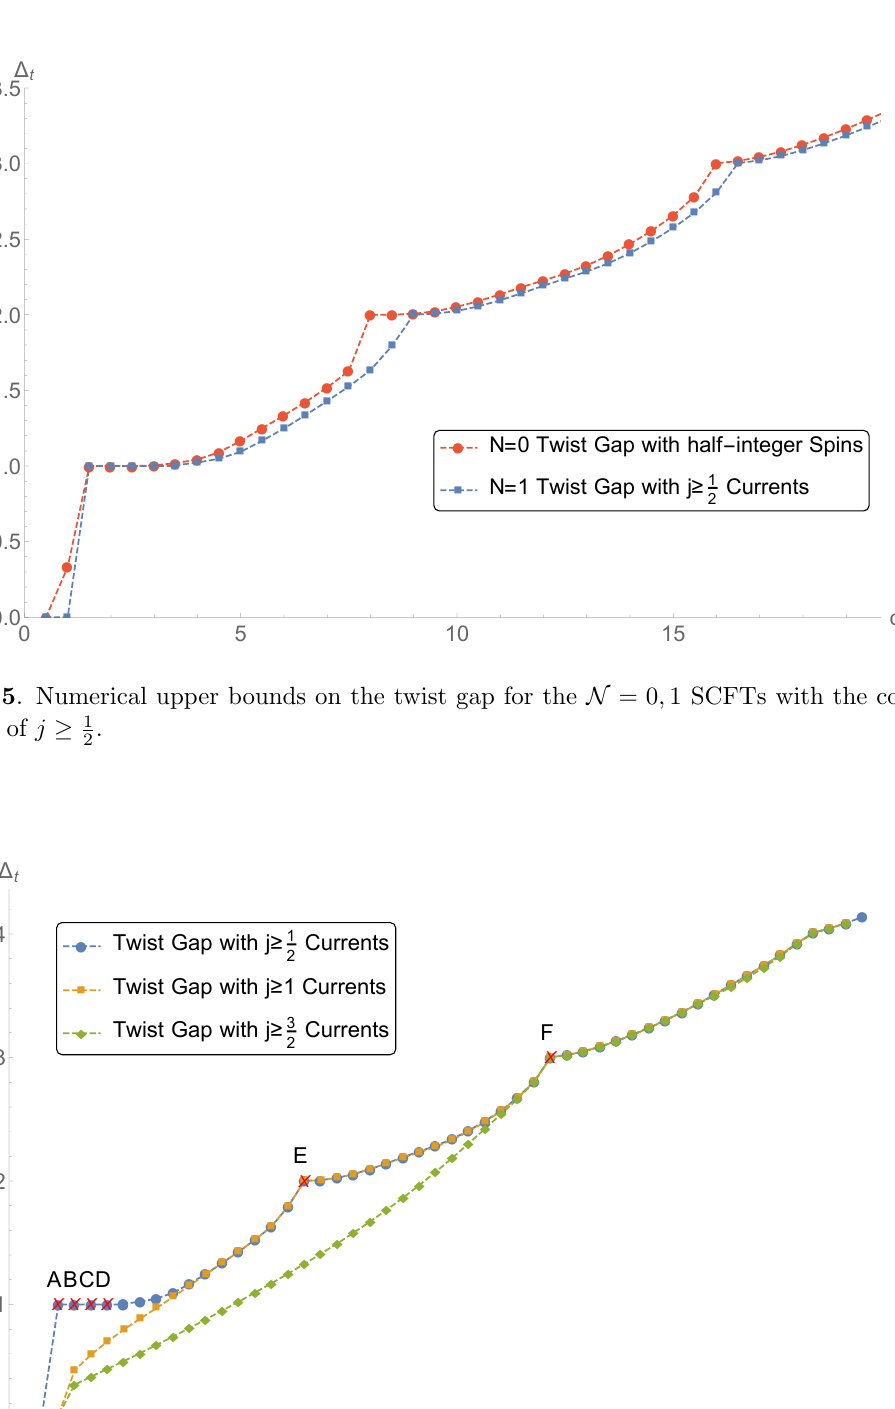
, j (cid:21) 1 and j (cid:21) 3 . 2 2